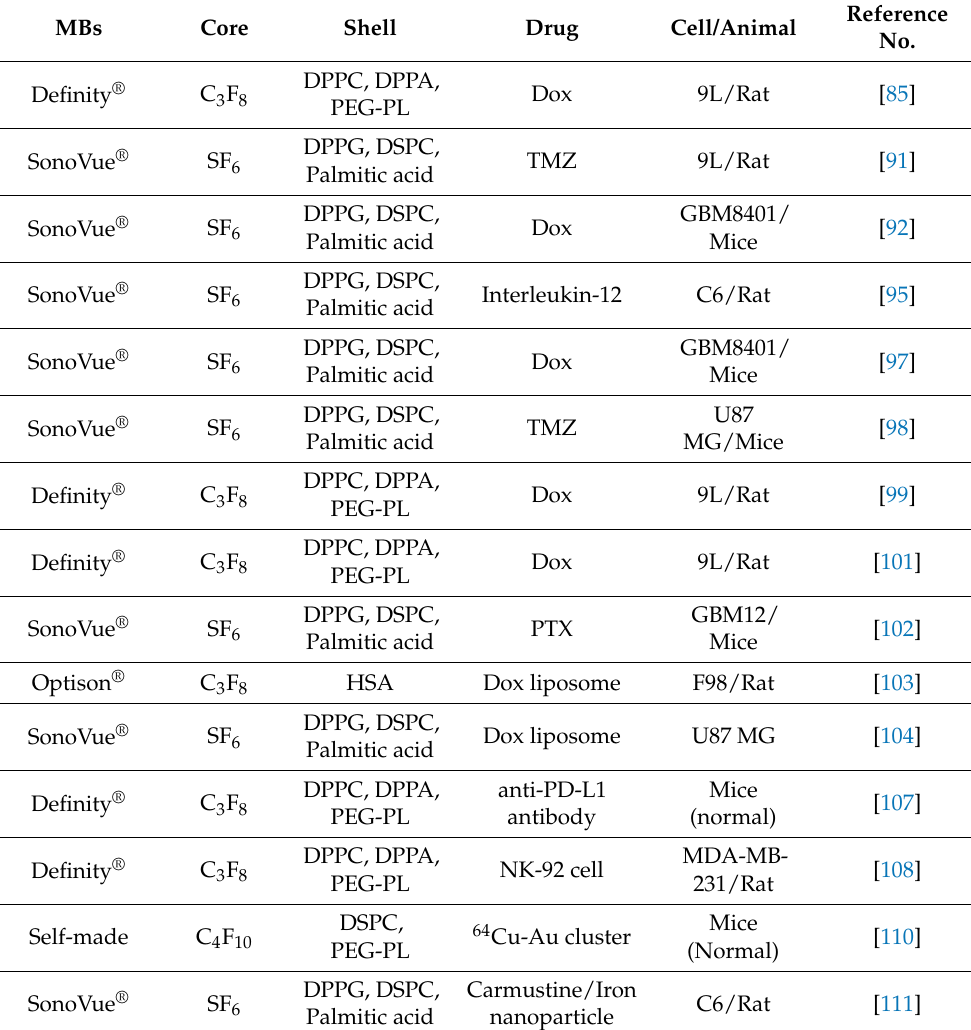
Table 1. Summary of the types of microbubbles, constituent materials, drugs, cells, and animals used in the co-injection